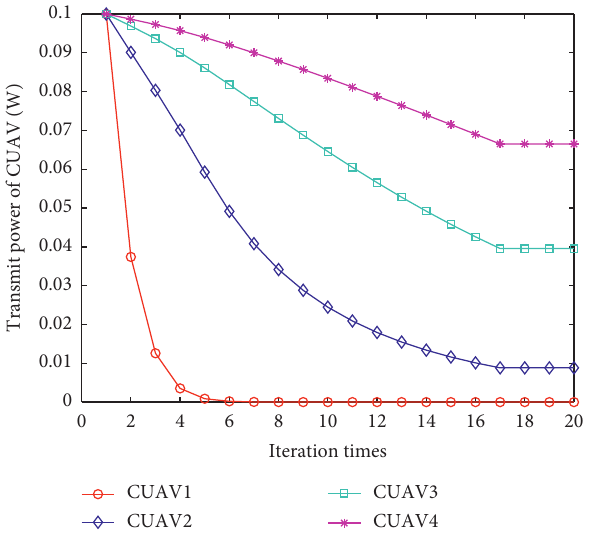
Figure 2: Transmitted power from CUAV for number of iterations.